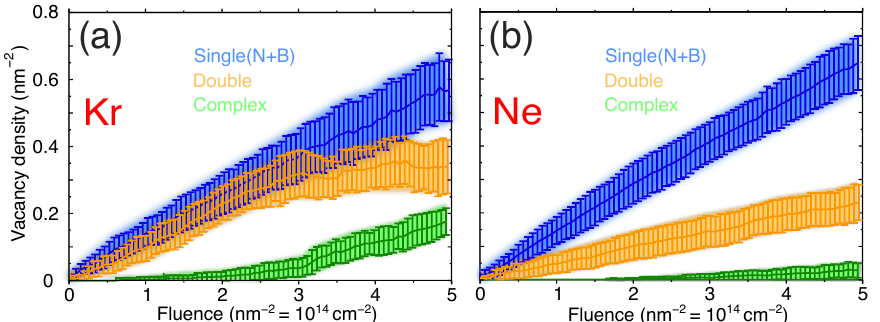
Figure 6. Accumulation of different types of vacancies during ion irradiation with different ions. Single (N + B) is the sum of single N and single B vacancies. The projectiles in this plot are: ( a ) Kr ions with 200 eV energy, and ( b ) Ne ions with 100 eV energy. The standard-deviations and averages for each incident projectile are shown with solid lines and vertical bars respectively. Note that to facilitate the comparison between defect densities and fluences, we present fluence in nm − 2 , not cm − 2 ).